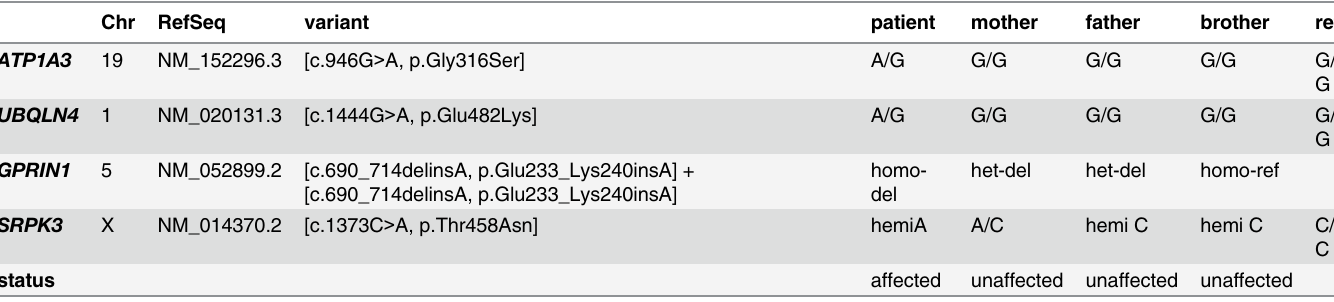
Table 2. Candidate variants detected by exome